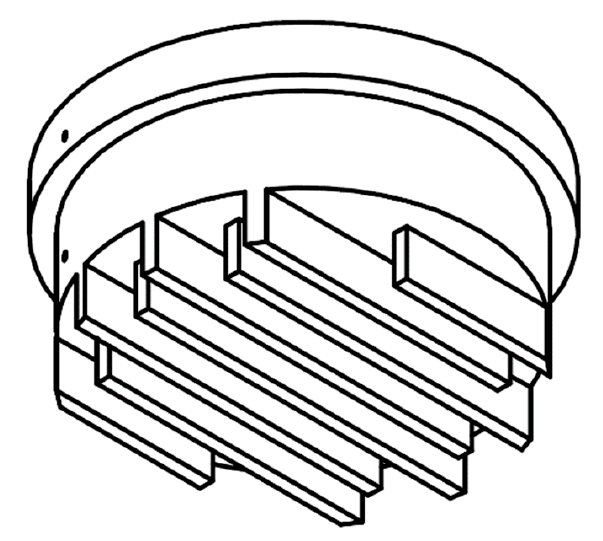
Figure 2. Schematic (3D) of the cooling copper block with labyrinth-like channels. (c) Steam generation: Connected to the condensation chamber via a hose (inner diameter of 16 mm), the steam generator (1 kW) was filled with demineralized water (500 mL). Its temperature was increased to a boiling point by the heater, which was connected to the transformer. Steam flow rate was determined in the preliminary tests from the amount of evaporated water in time as a function of voltage. Adjusting the voltage on the transformer allowed the evaporation of water at different rates (2, 4, and 6 mL/min) and the continuous production of steam (2, 4, and 6 g/min, respectively). In the case of the highest investigated steam flow rate (6 g/min), the steam velocity in the system was calculated to be below 1 m/s. Steam filled the whole chamber and left through the outlet opening of 16 mm in